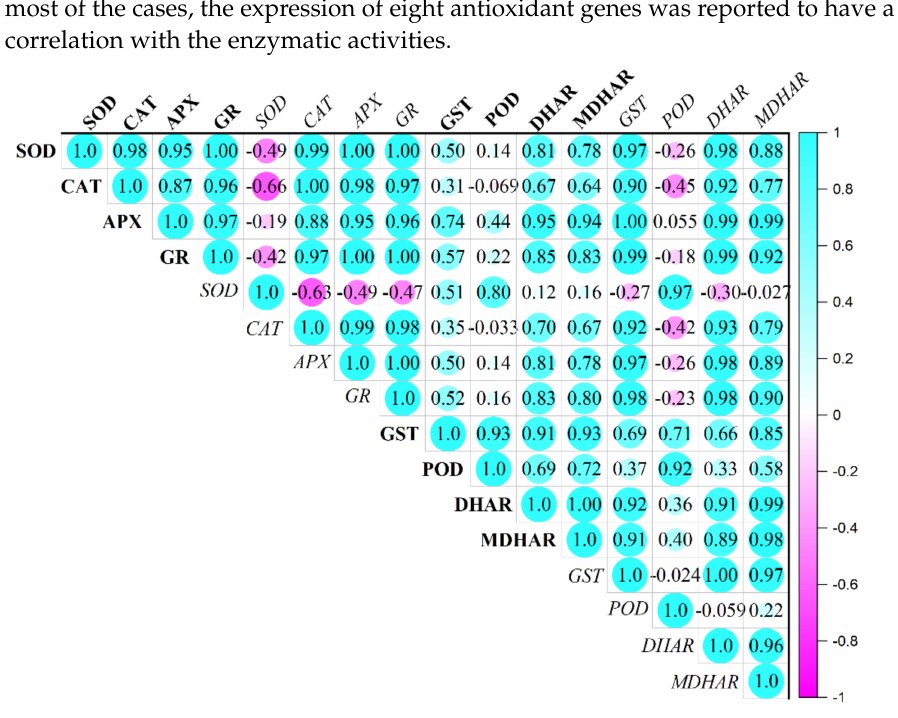
Figure 9. Pearson correlation analysis of antioxidant enzymatic activity (illustrated in bold font) and genes (illustrated in italics font) related to